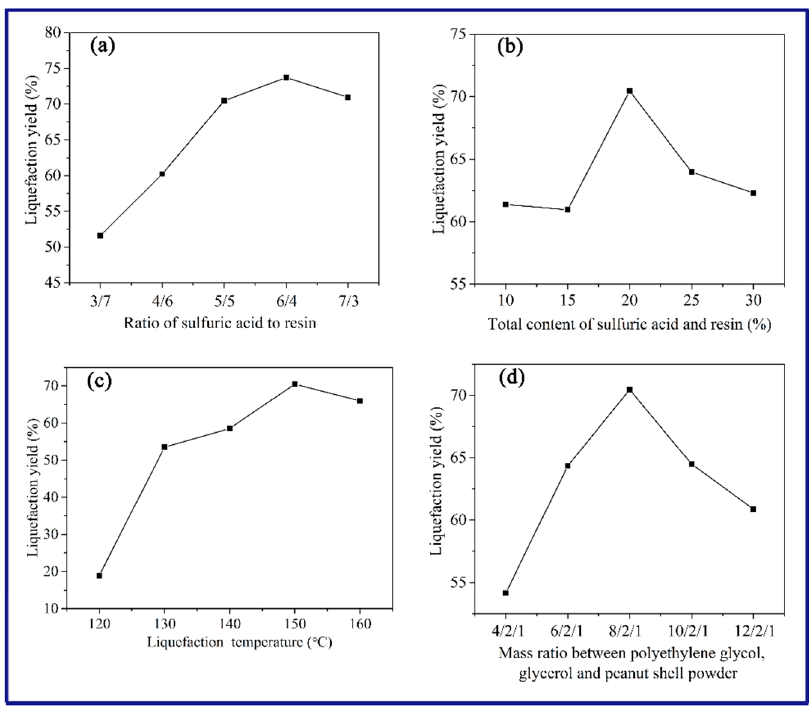
Figure 1. Liquefaction yield under different reaction parameters of ( a ) ratio of sulfuric acid to resin, ( b ) total catalysts content, ( c ) liquefaction temperature and ( d ) PEG-G-PSP (polyethylene glycol–glycerol–peanut shell powder ratio.